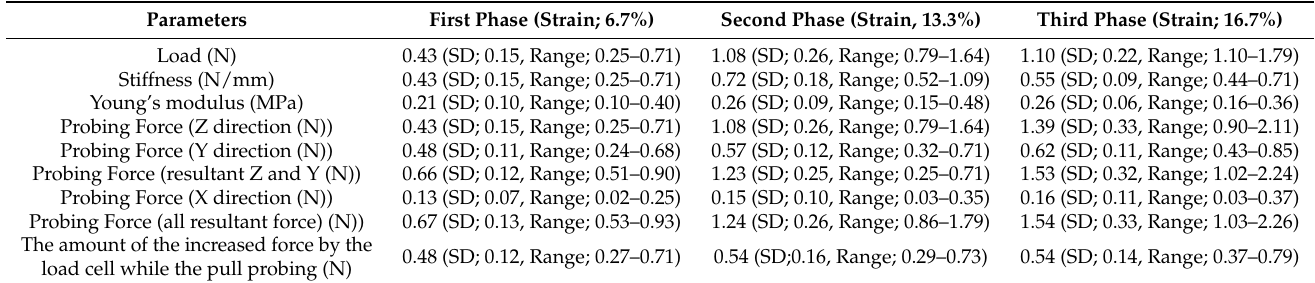
Table 1. The measurements with the tensile tester.